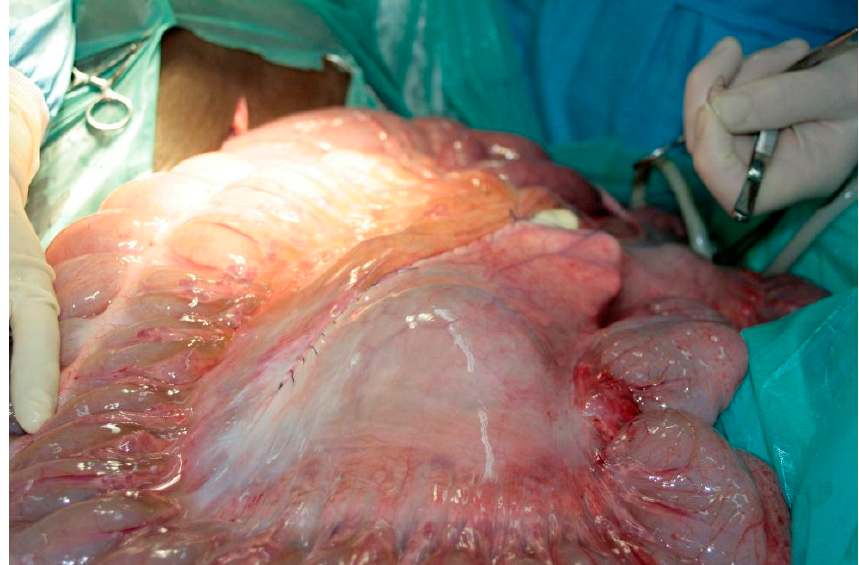
Figure 4. Solving the primary problem by suturing abnormally formed mesentery in the colon.